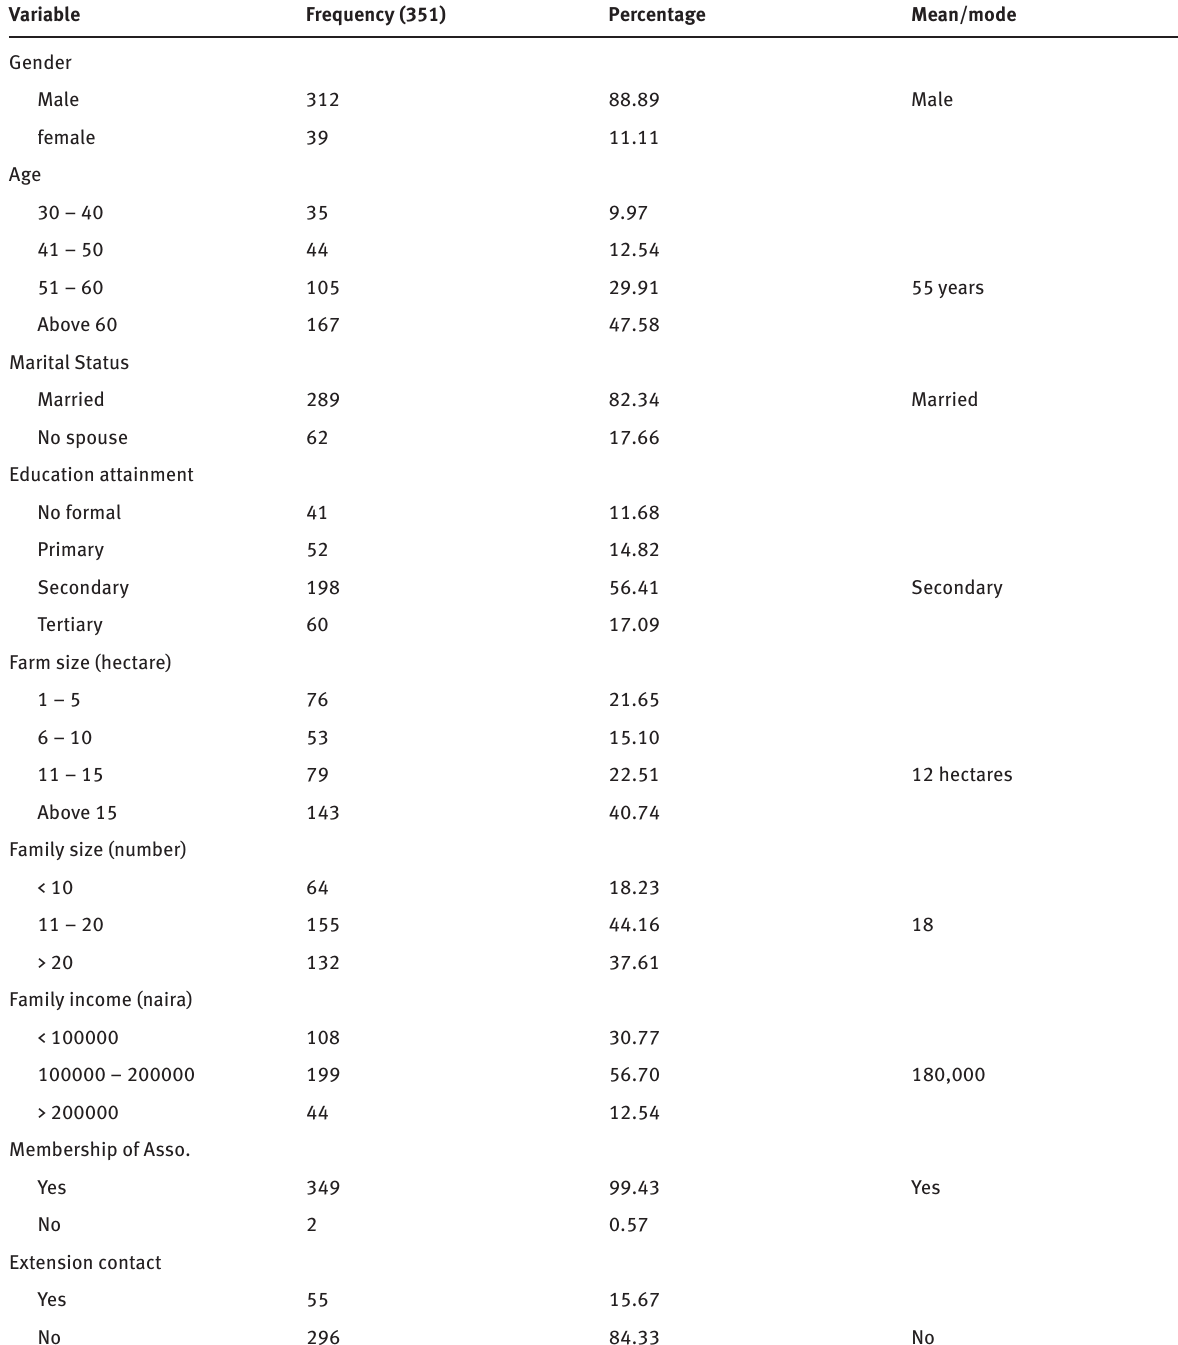
Table 2: Socioeconomic characteristics of